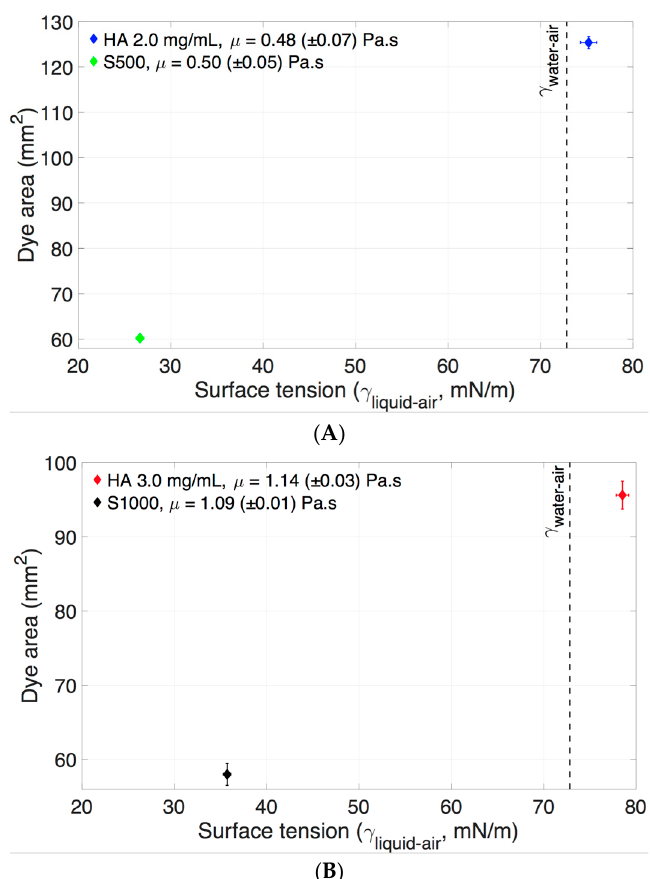
Figure 15. The effect of surface tension on dye area at high Re into vitreous substitutes of equivalent viscosities. The higher surface tension difference between air/vitreous substitutes and air/water resulted in a lower injected dye dispersion area. ( A ) HA (2.0 mg/mL) and S500, ( B ) HA (3.0 mg/mL) and S1000 and (vertical black dotted line) the surface tension of water and air.